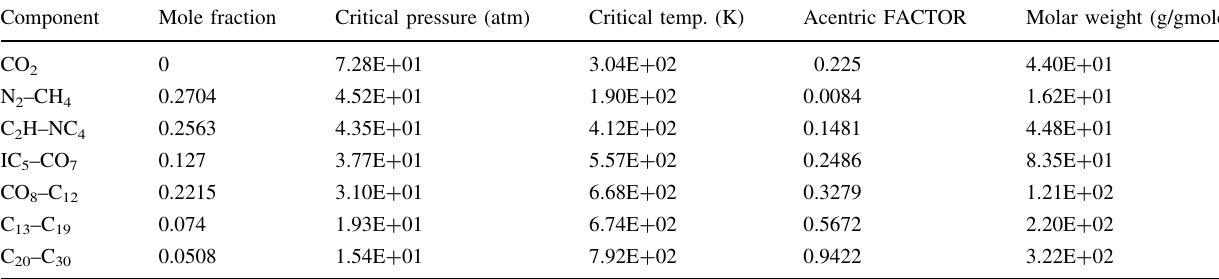
Table 3 Compositional data for the Peng–Robinson EOS in the model oil Component